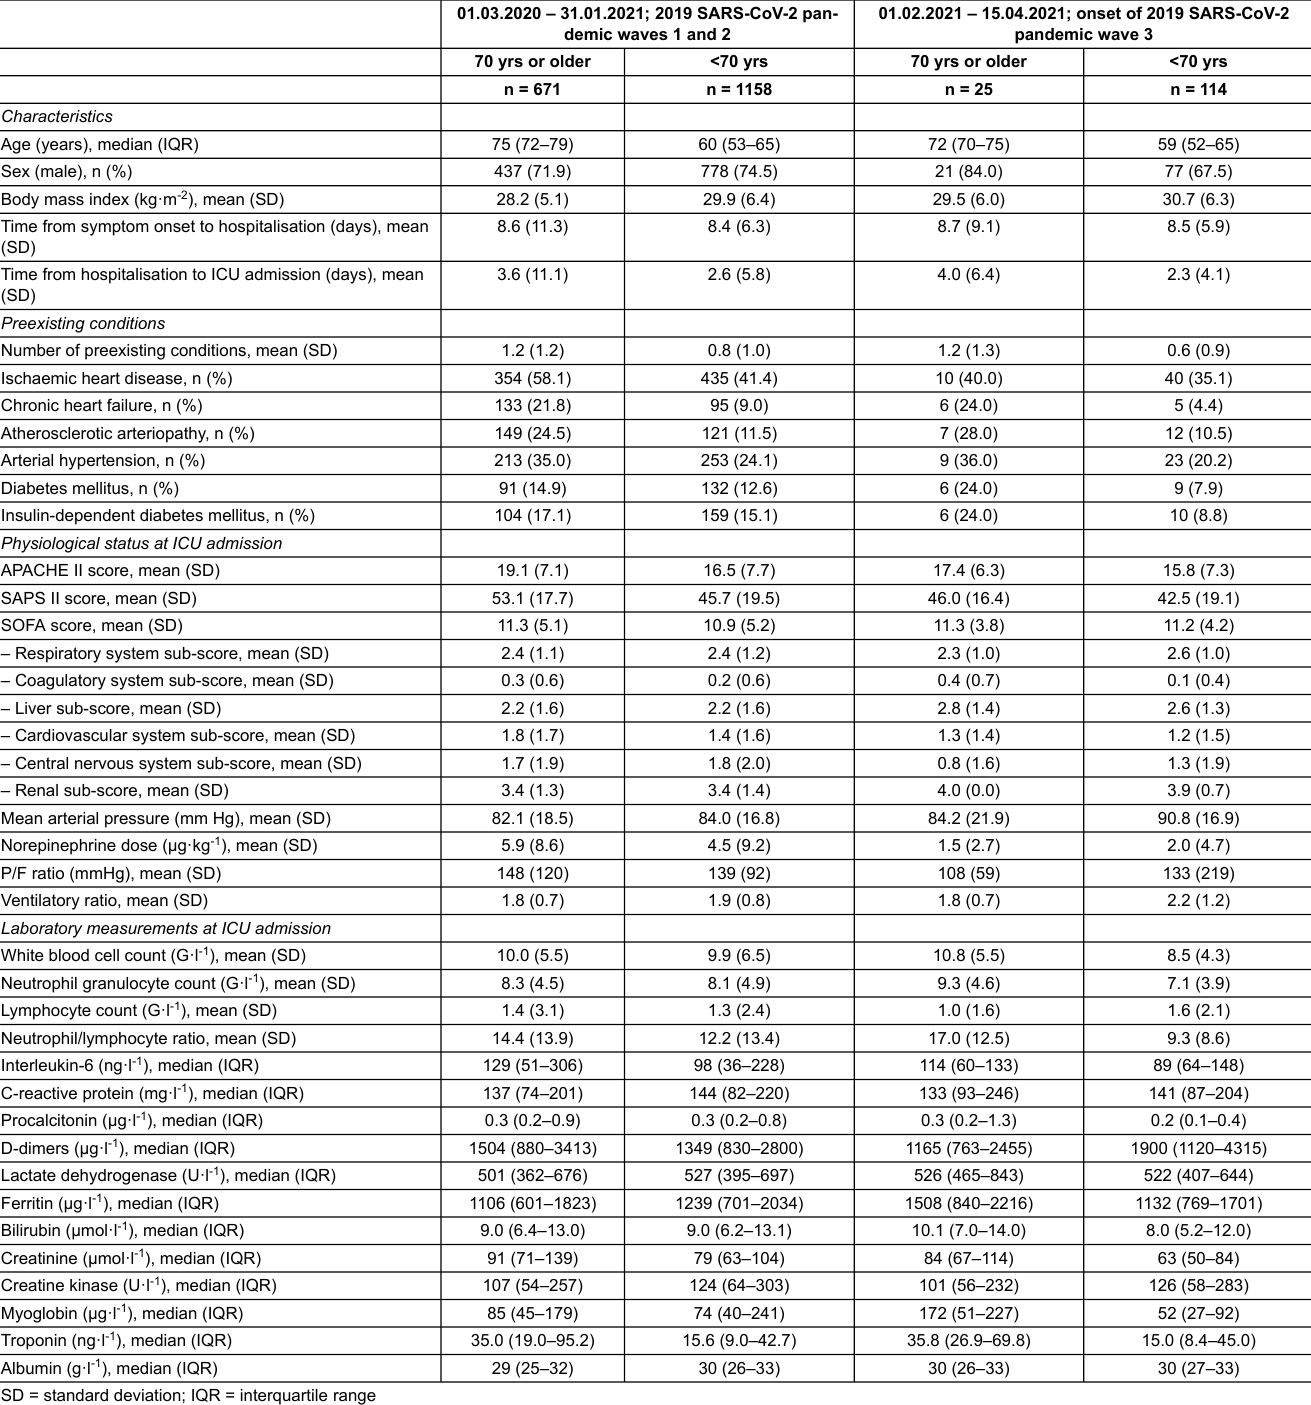
Table S3: Characteristics of critically ill COVID-19 patients at ICU admission at the onset of the third wave of SARS-CoV-2 infections in Switzerland in comparison with the previ- ous pandemic course, stratified by age